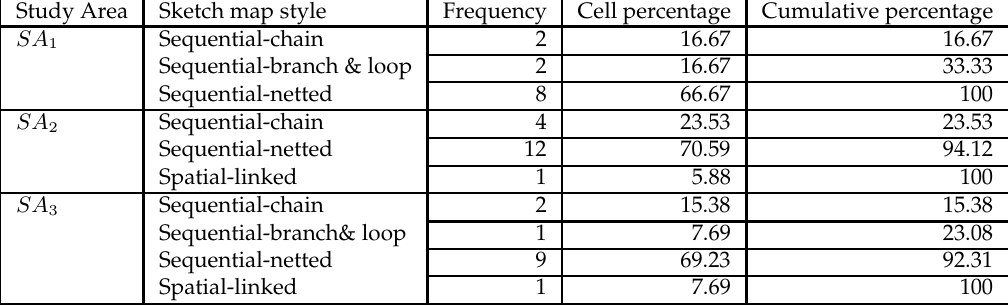
Table 5: Frequency and percentage of sketch map